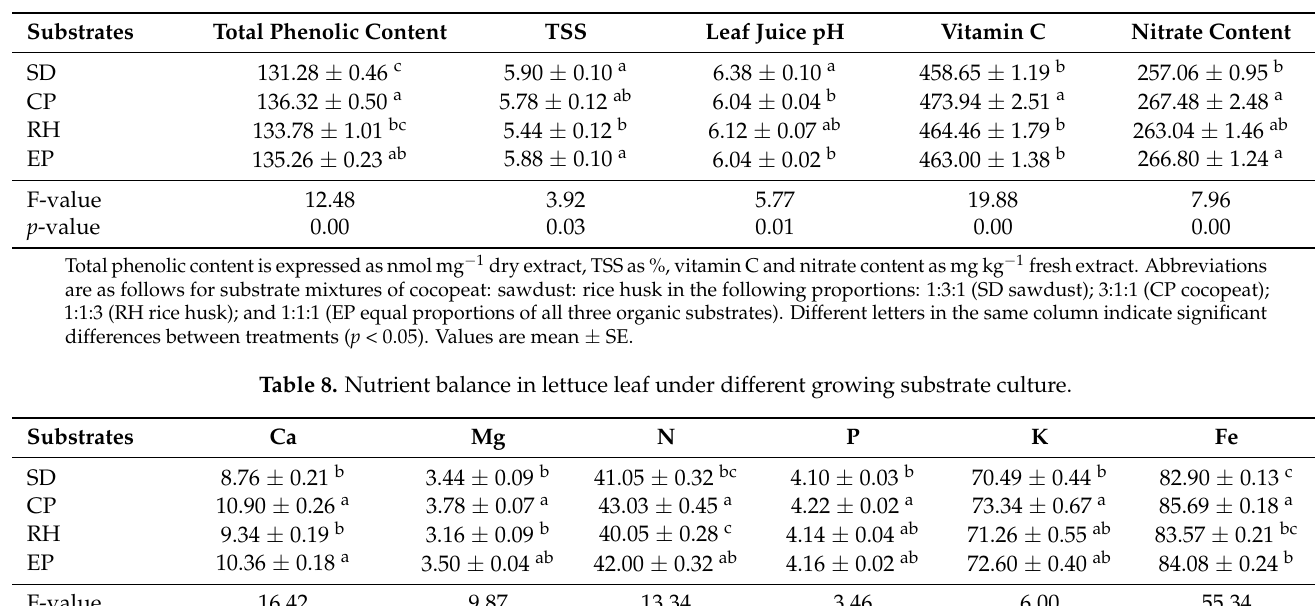
Table 7. Biochemical composition in lettuce leaves under different growing media culture.